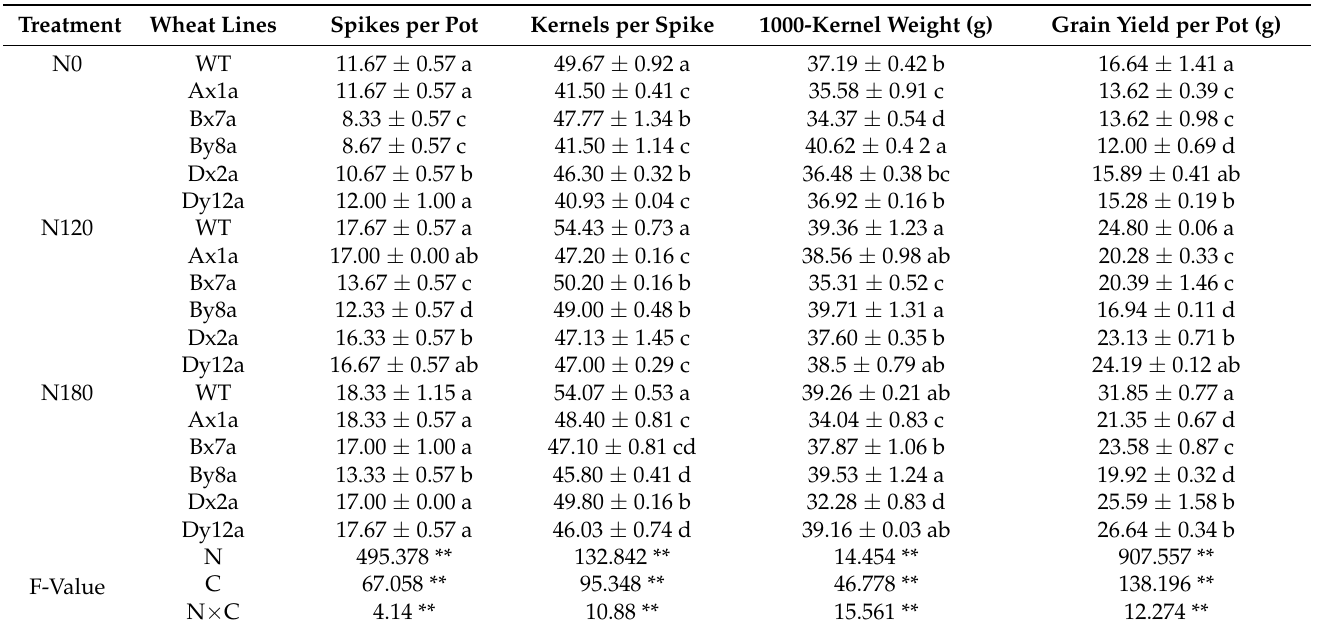
Table 1. Grain yield and its components of wheat lines with the absence of HMW-GS under different N